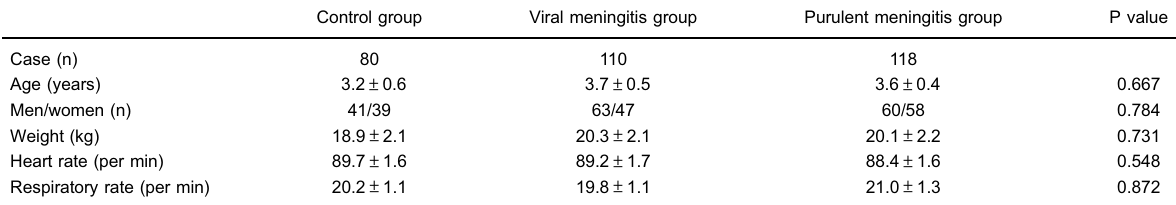
Table 1. Baseline